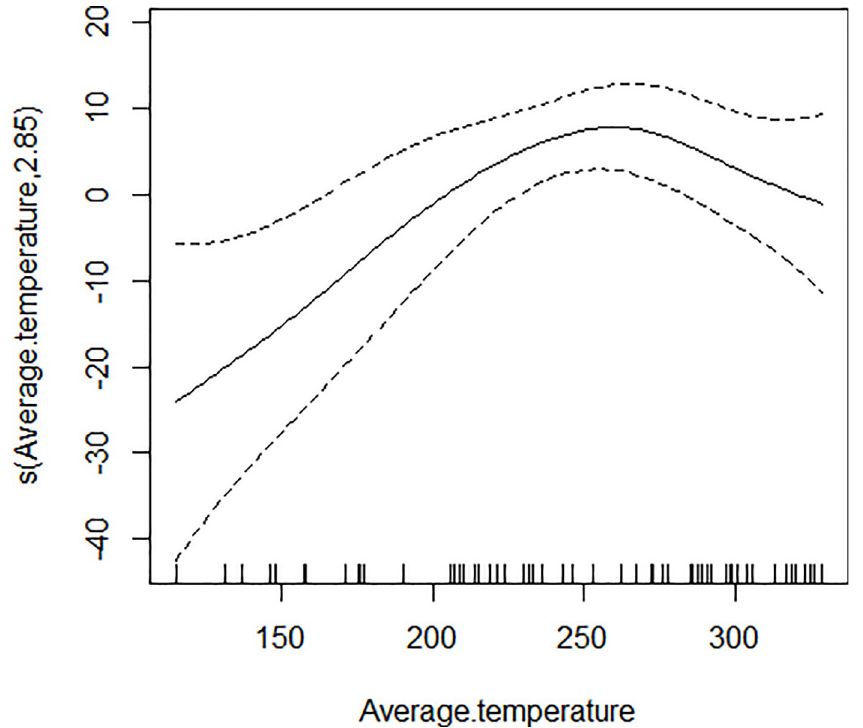
Fig 6. The relationship between HI and average temperature.